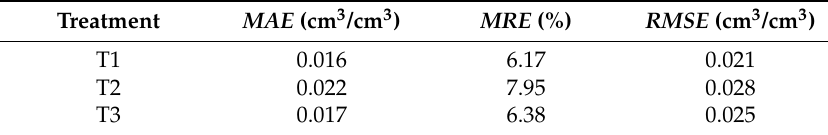
Figure 3. The linear relationship between the experimental and simulated values of SWC. ( a ) T1 treatment; ( b ) T2 treatment; ( c ) T3 treatment. Table 5. The model accuracy evaluation indicators.